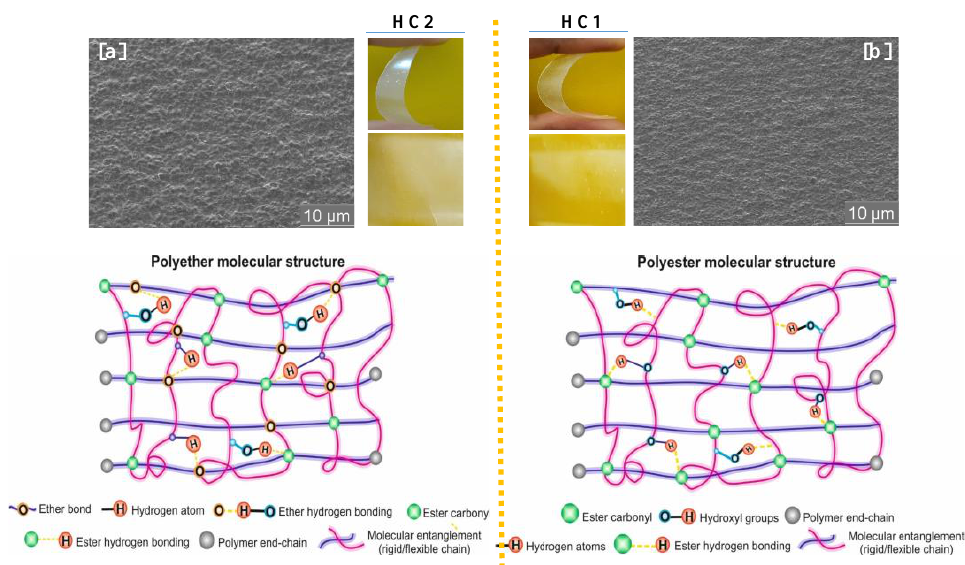
Figure 10. Schematic representation of the molecular structure and permeability differences in poly(ether-ester)s. SEM micrographs of HC2 ( a ) and HC1 ( b ) polymers.